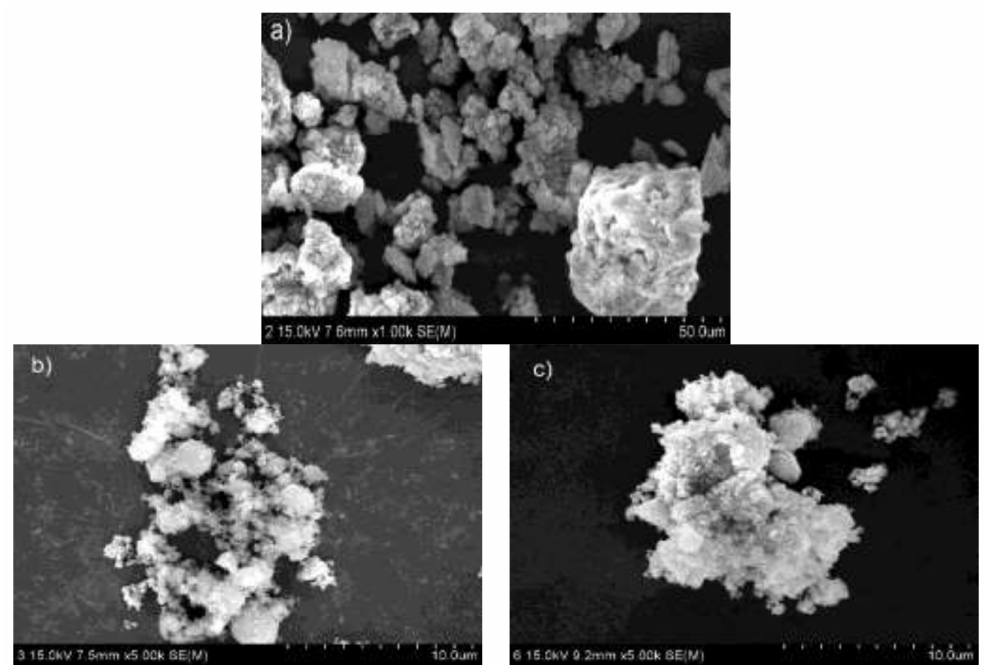
Figure 5. SEM images of the dross before and after ball milling: ( a ) as-received; ( b ) milled at 400 rpm, ( c ) milled at 700